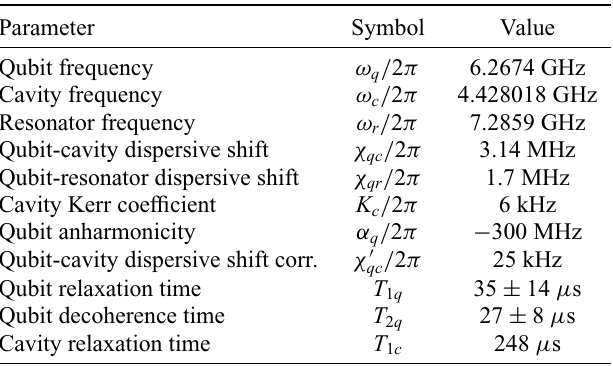
TABLE II. Parameter values for the Hamiltonian in Eq. (1) and measured coherence times. Qubit relaxation and decoherence times vary over time and are given with two sigma